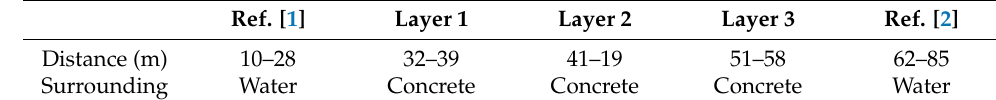
Table 1. Information about different fiber sections.